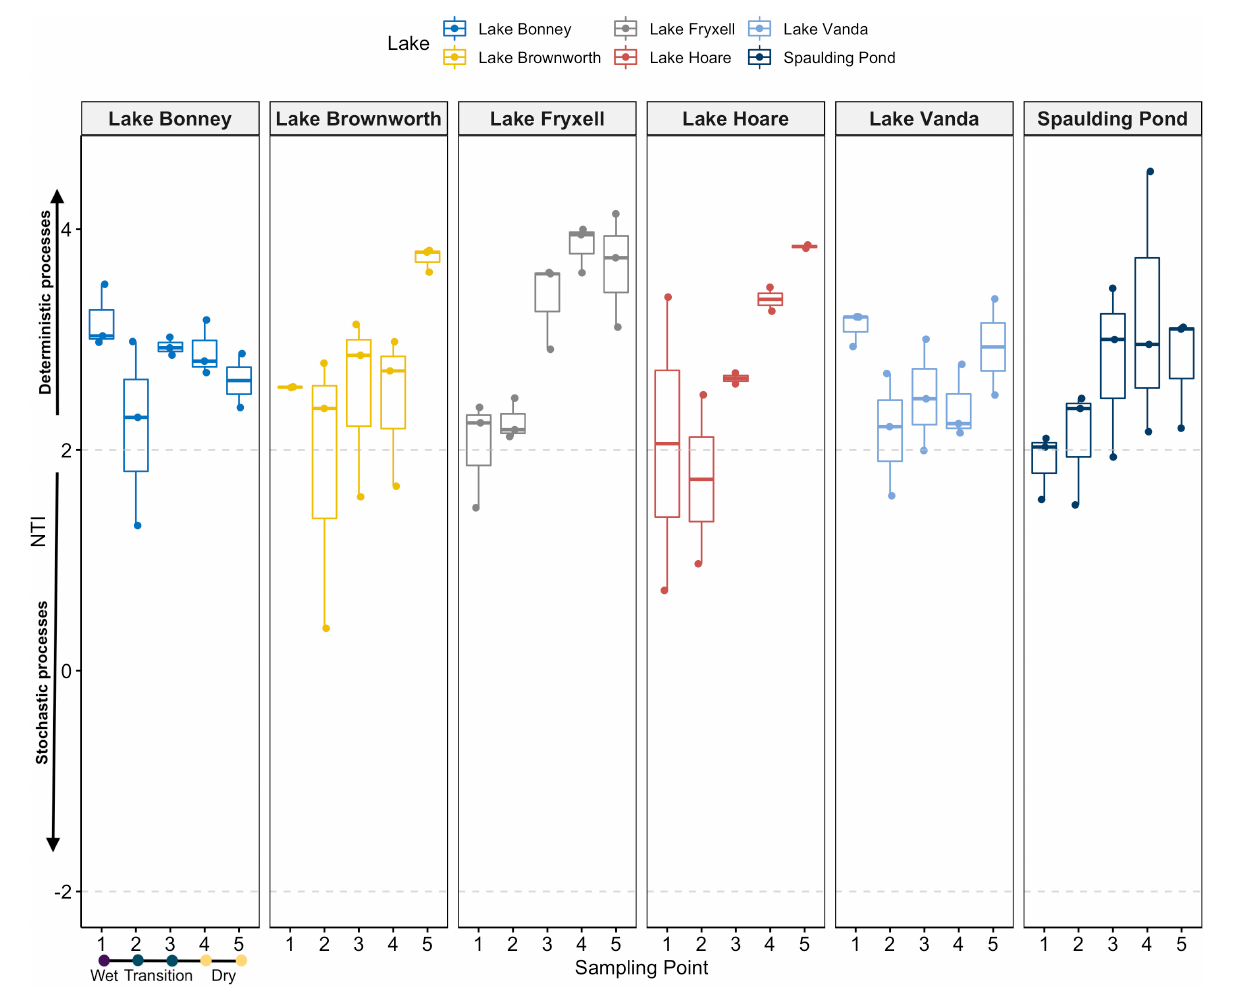
of taxa that cannot tolerate such selective pressures